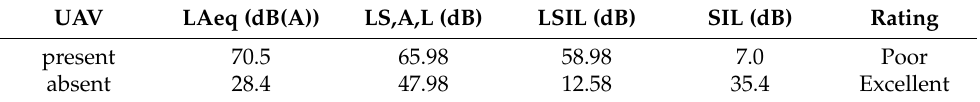
Table 1. Speech intelligibility in the laboratory in the presence of the UAV and the absence of the UAV.